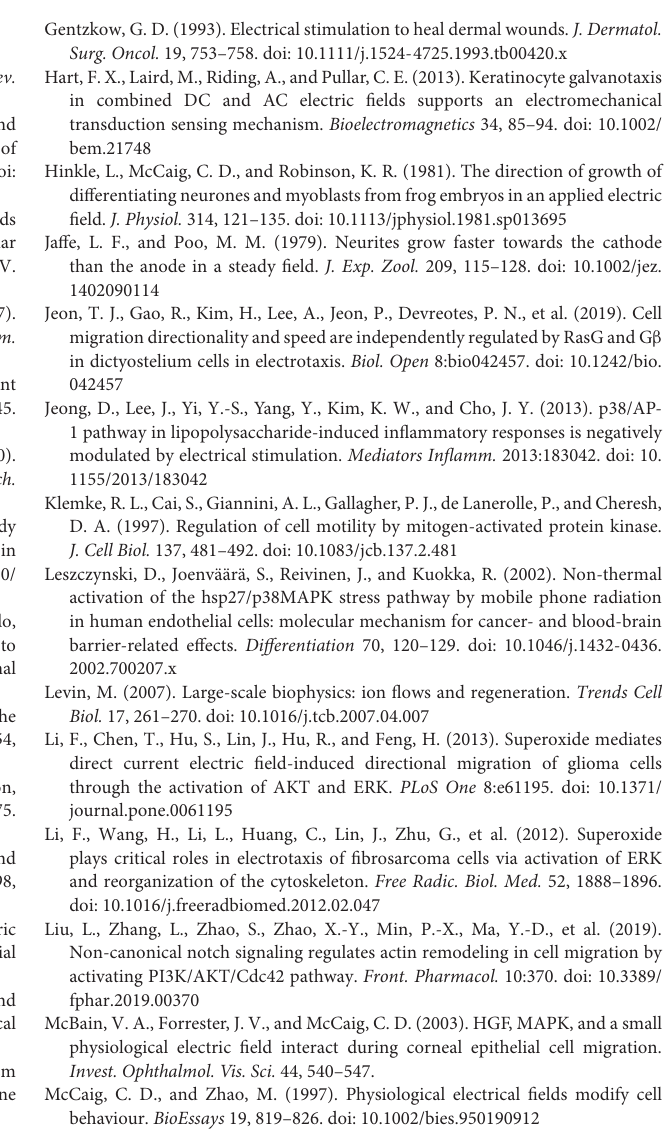
Supplementary Figure 4 | Effects of PI3K inhibitor on EF-induced cellular migration. Inhibition of PI3K (PI3K-i) significantly decreased migration velocity (A) and directedness (B) responses. PI3K inhibitor LY294002 (50 µ M). HK-2 cells were subjected to EFs of 200 mV/mm for 6 h ( n = 62–66 cells). ∗∗∗ P < 0.001 ,